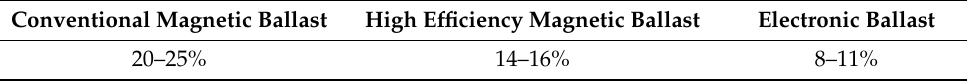
Table 2. Range of energy losses depending on the type of auxiliary ballast of fluorescent lamps